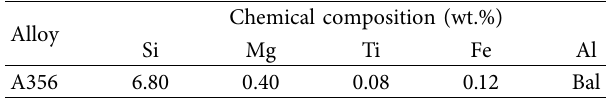
Table 1: The chemical compositions of A356 alloy used in this study (in wt.%). Chemical composition (wt.%) Alloy Si Mg Ti Fe Al A356 6.80 0.40 0.08